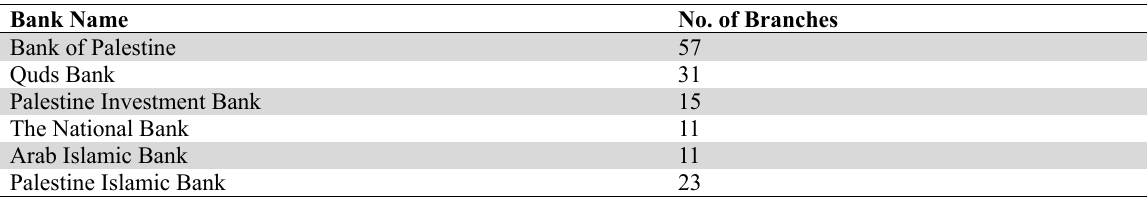
Listed Banks in Palestine Bank Name No. of